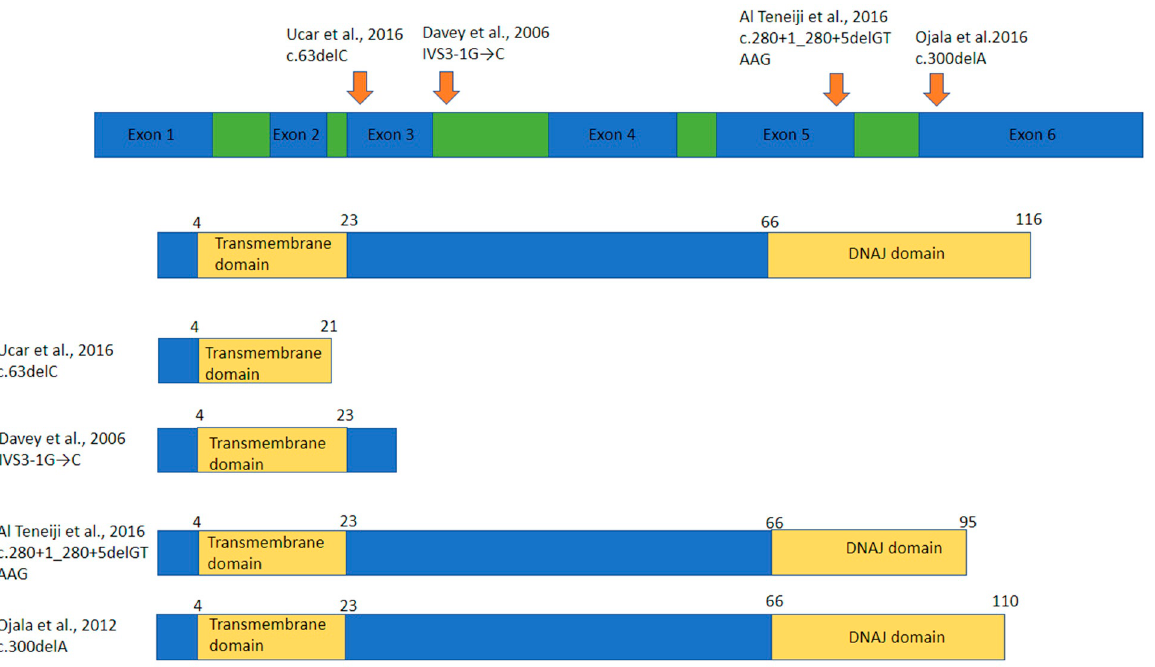
Figure 2. Described mutations in DnaJ heat shock protein family (Hsp40) member C19 (DNAJC19) [45,66–68]. Location of known mutations in DNAJC19 mRNA and their subsequent protein products. Green represents introns, blue represents exons, important domains in protein products are in yellow with residue numbers above each protein.